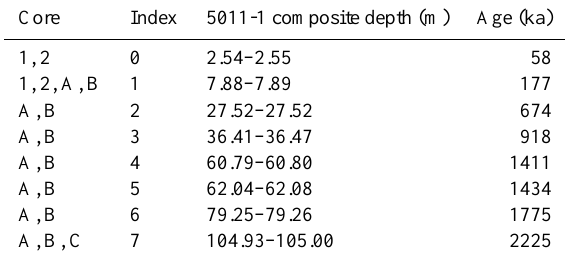
Table 3. Positions and ages of tephra layers identified in Lake El’gygytgyn sediments. Core labels indicate: 1 – PG1351, 2